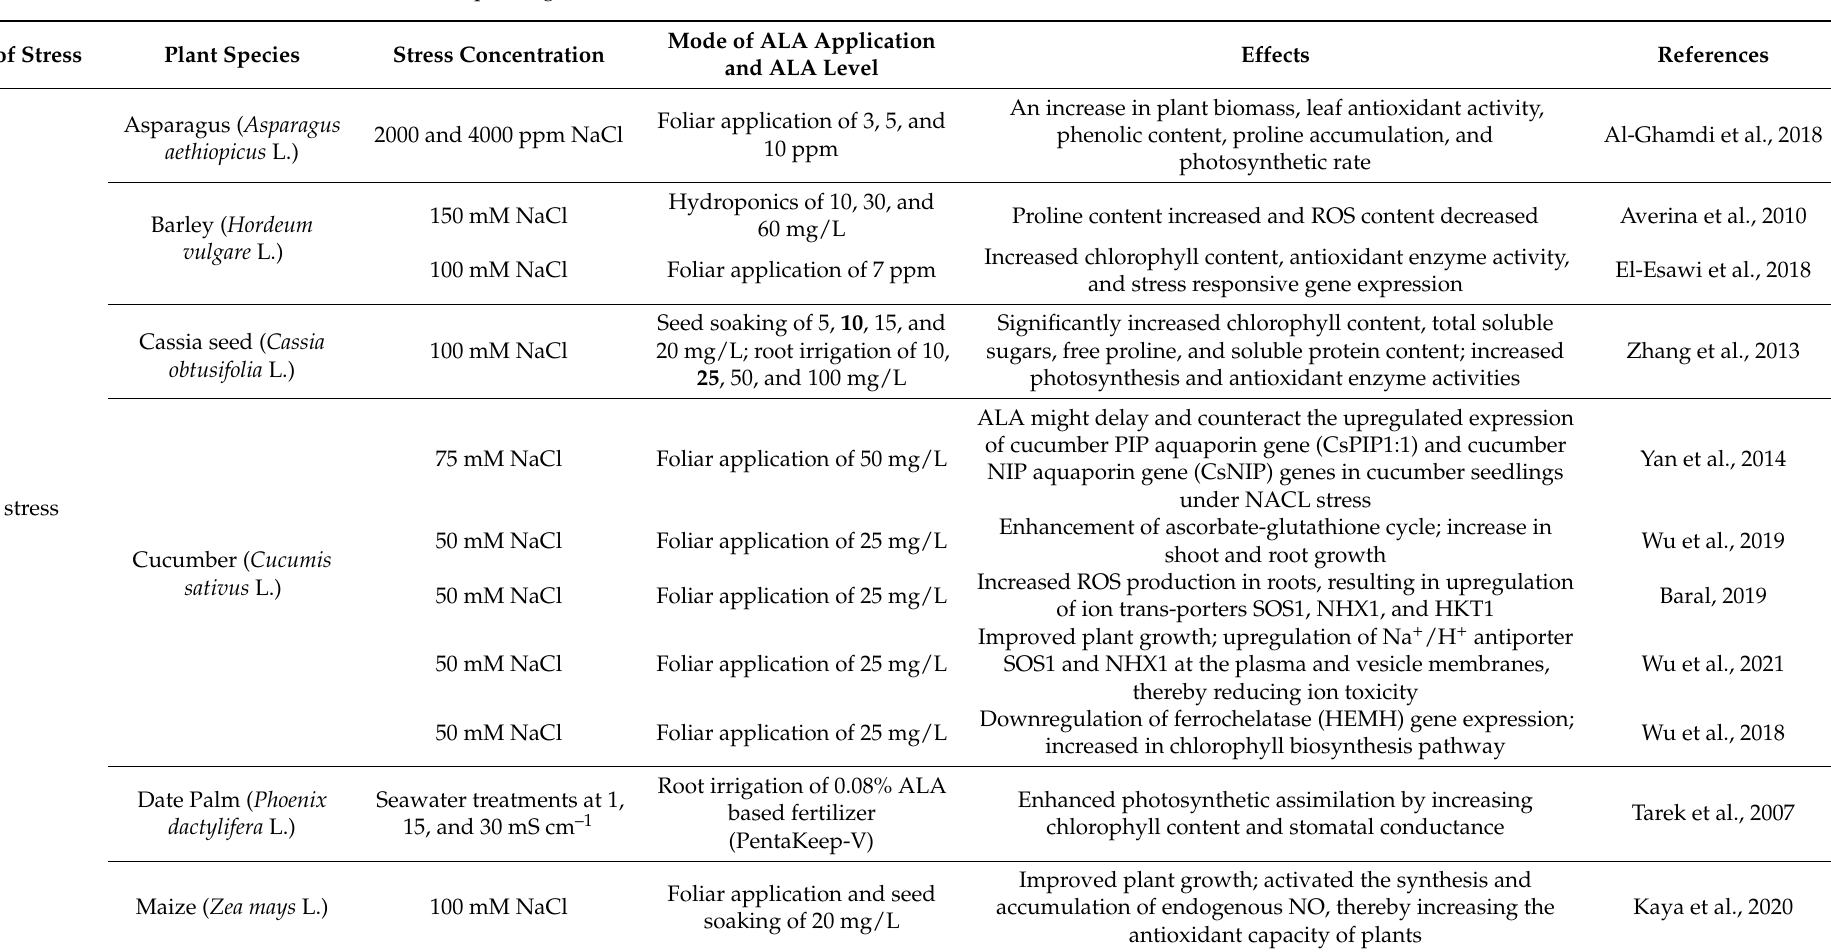
Table 1. Effects of ALA priming on the tolerance to environmental